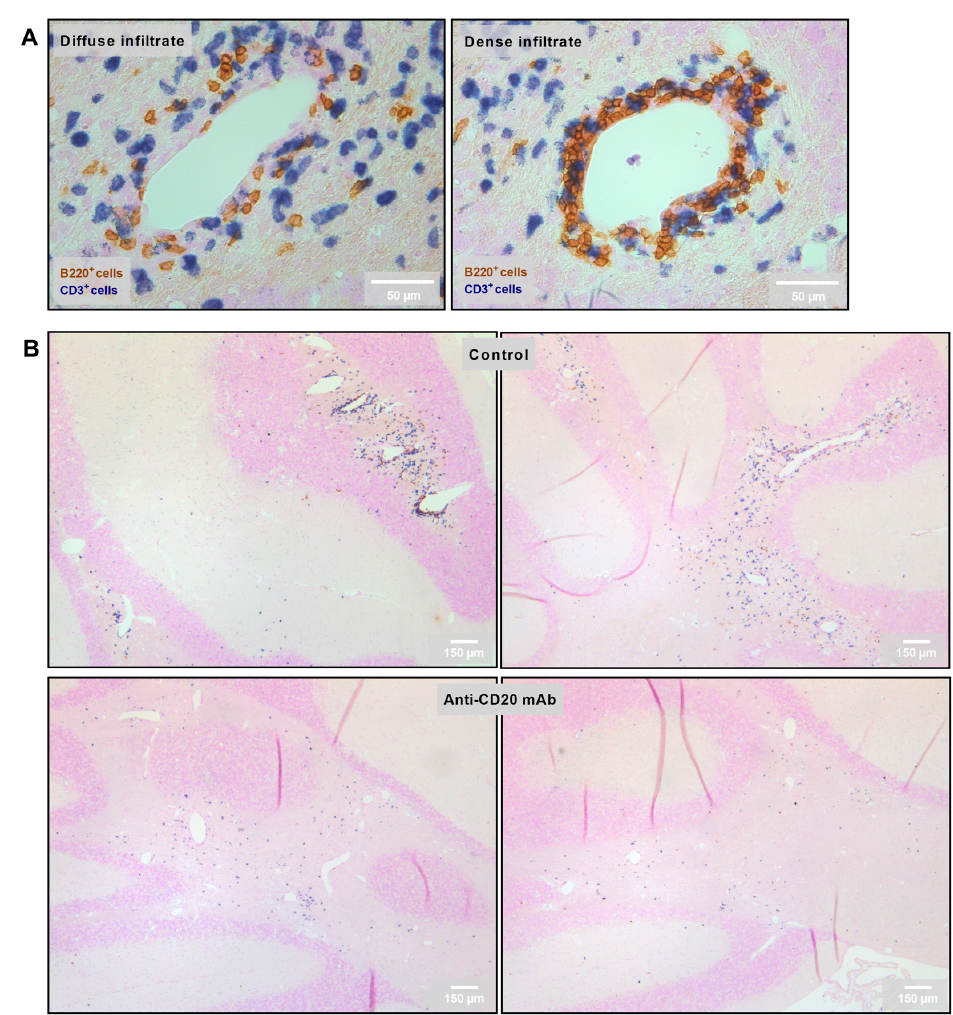
Figure 4. Representative images of CNS infiltration in isotype control- and anti-CD20 mAb-treated groups: ( A ) Categorization of infiltrates depending on the diffuse vs. dense infiltration of lymphocytes into the CNS. B220 + cells were defined as B cells, and CD3 + cells as T cells. ( B ) Representative images of cerebellar infiltration in isotype control- (upper row) vs. anti-CD20 mAb (lower row)-treated groups.